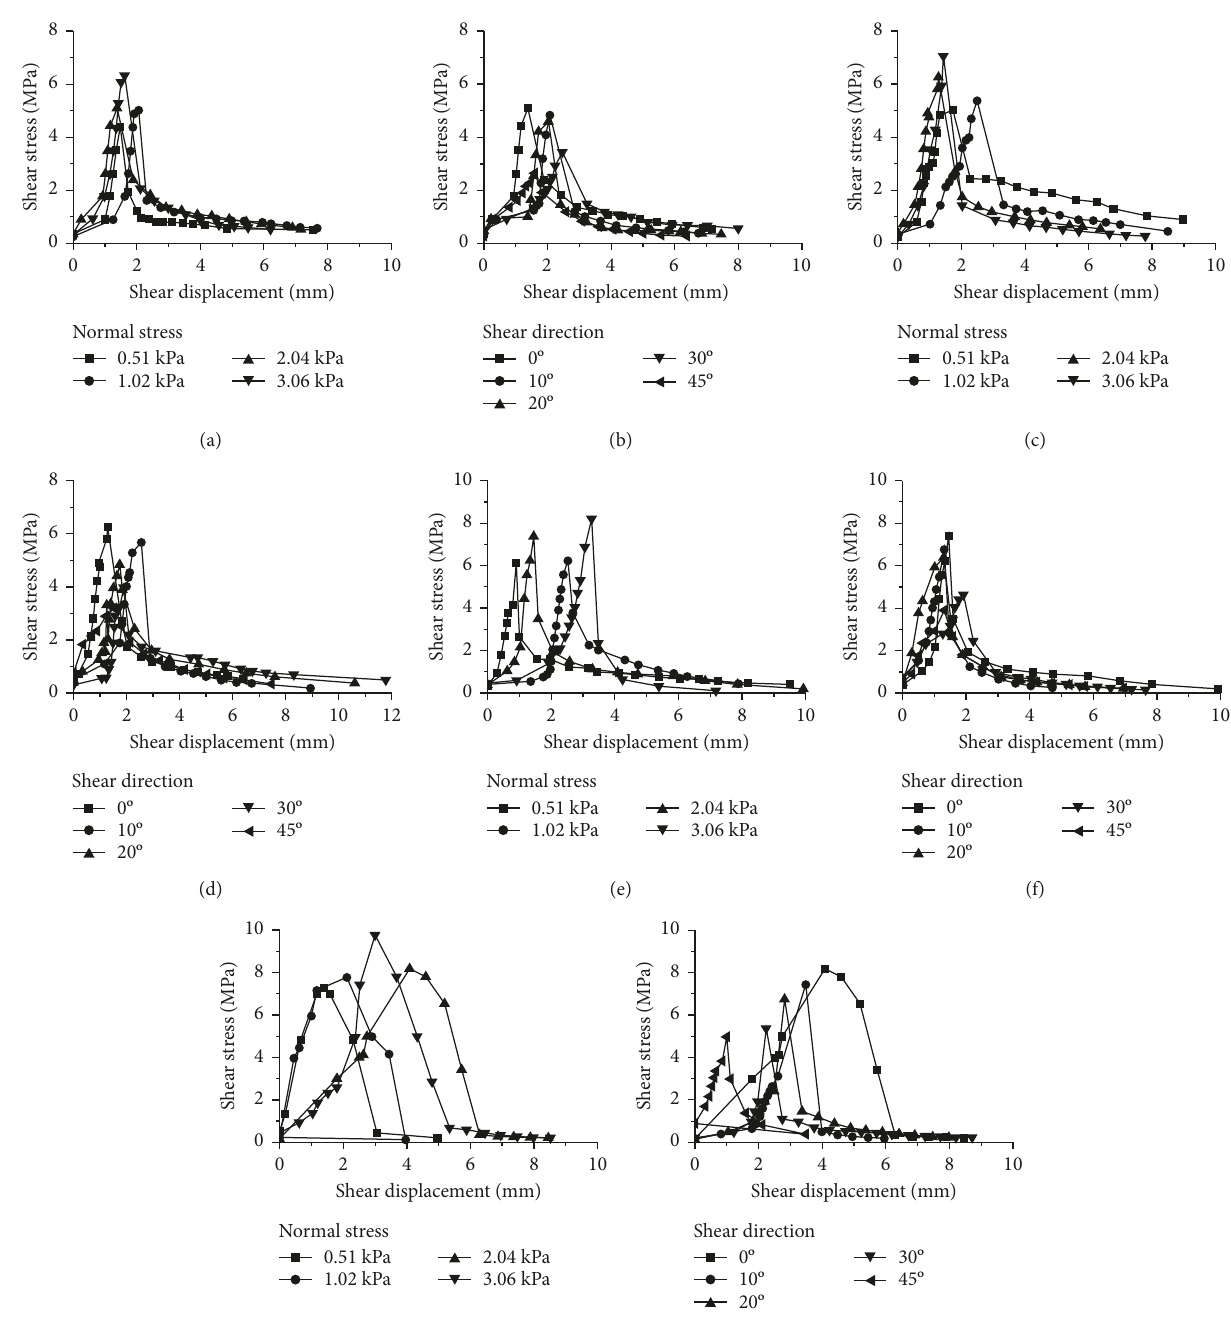
Figure 14: Shear strengths and displacements of discontinuity for type II. (a) AH (c) AH 4mm and SD (cid:31) AH 8 mm and SD (cid:31)